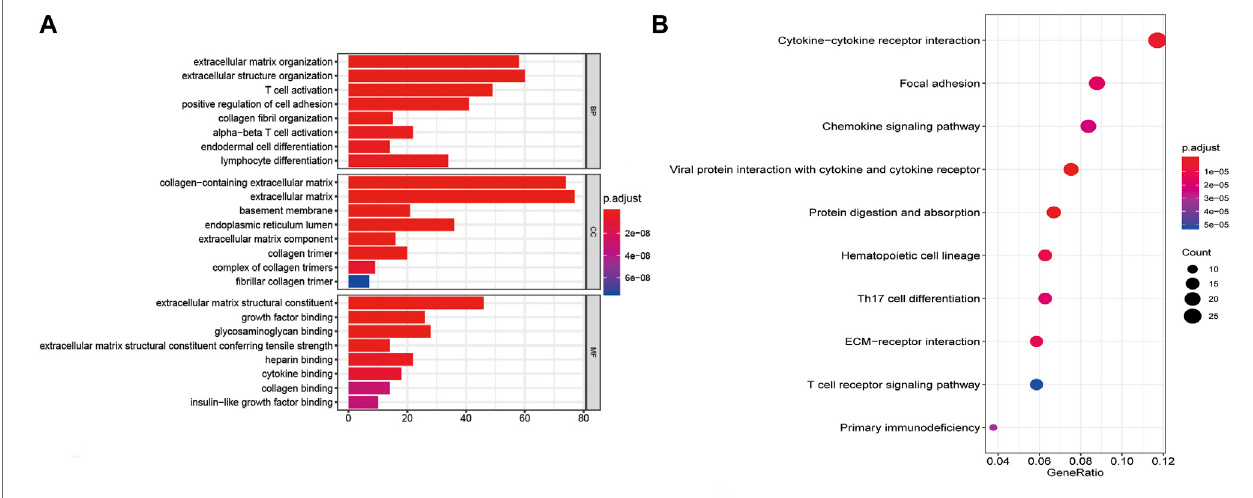
FIGURE 8 | Potential functions and signaling pathways related to the autophagy-related genes of the gene signature. (A) GO analysis. (B) KEGG analysis.